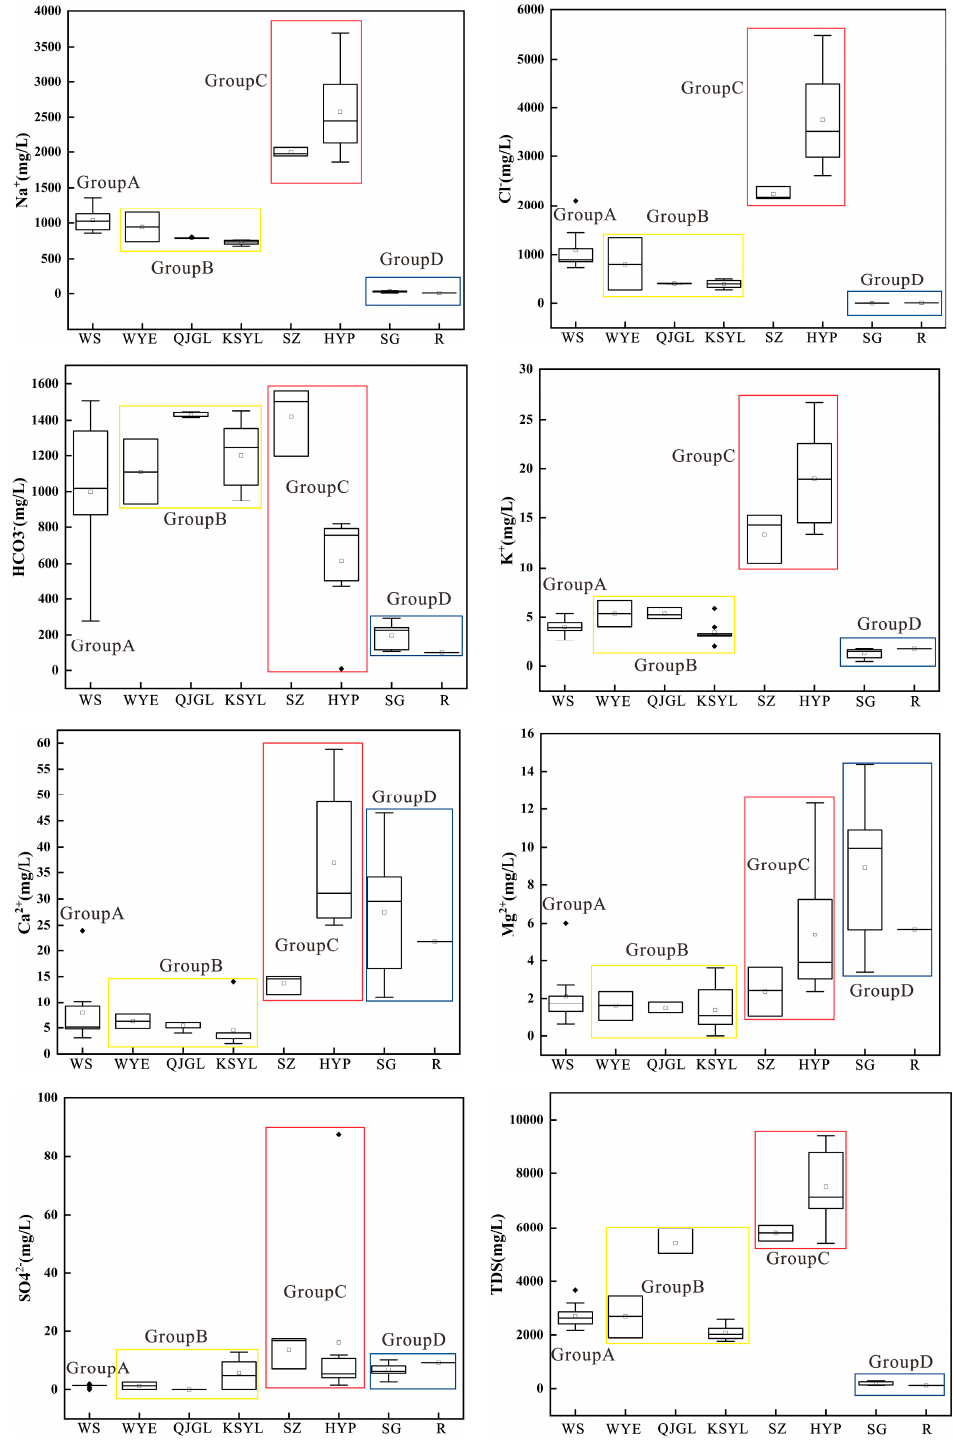
Figure 4. Box plots of main hydrochemical components in water samples from the study area.